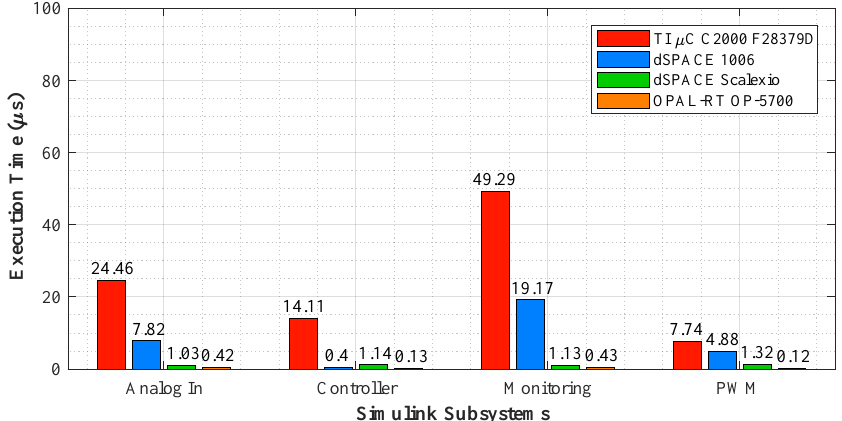
Figure 12. Computation time profiles for the PR ( αβ ) controller of the Full version file.